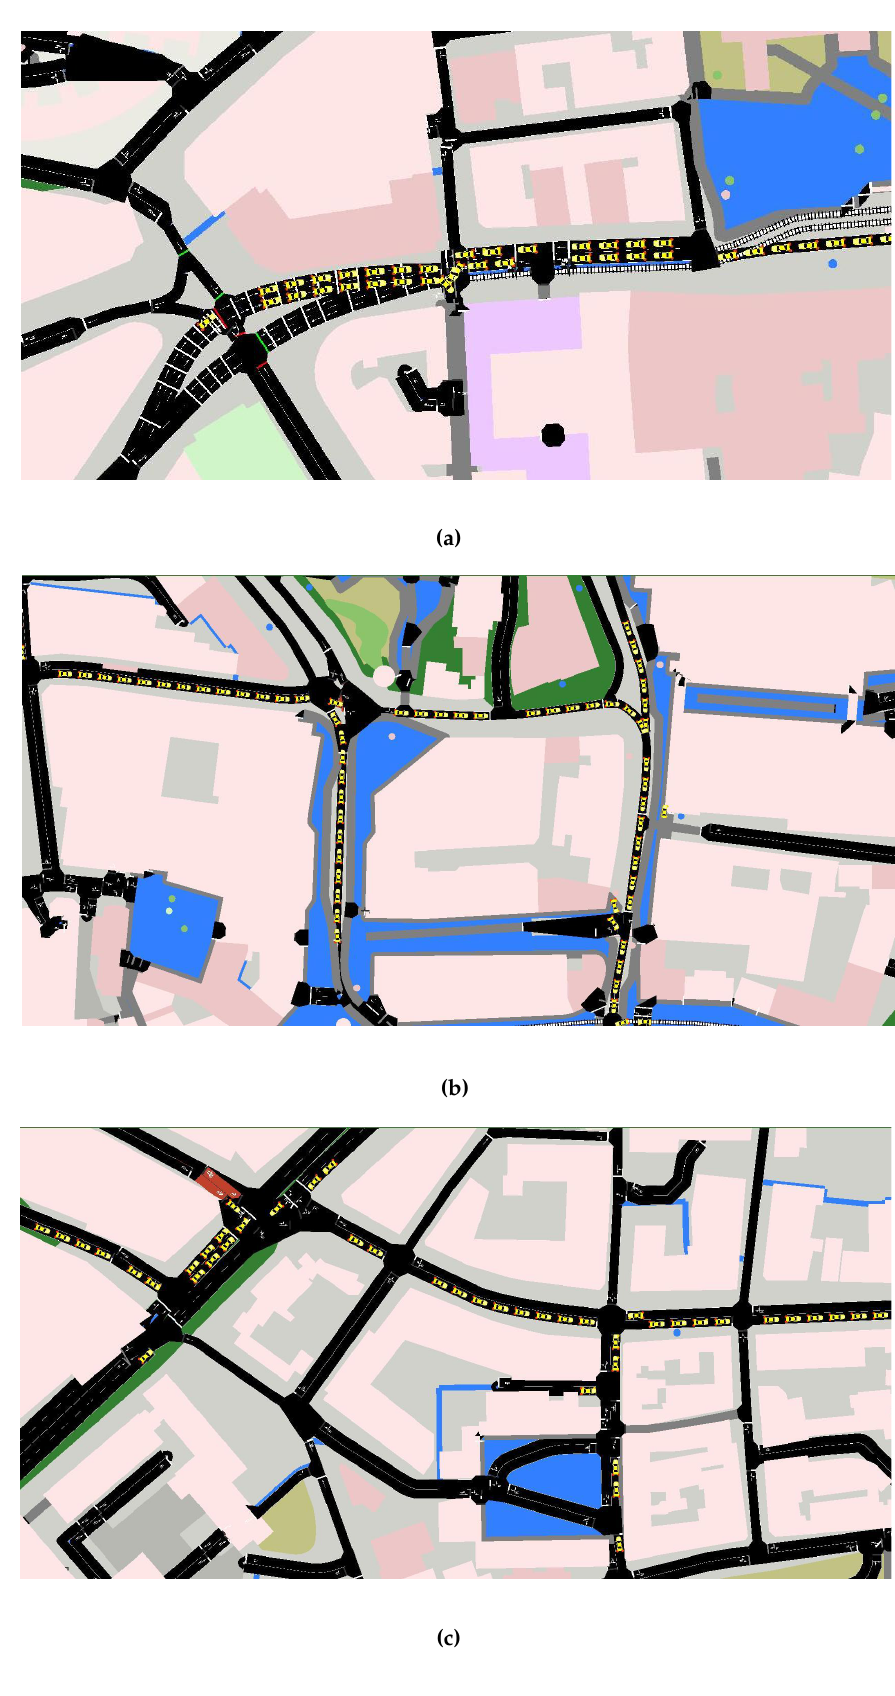
Figure 6. The zoomed places showing traffic congestion on some roads. ( a ) Traffic Congestion Area 1; ( b ) Traffic Congestion Area 2; ( c ) Traffic Congestion Area